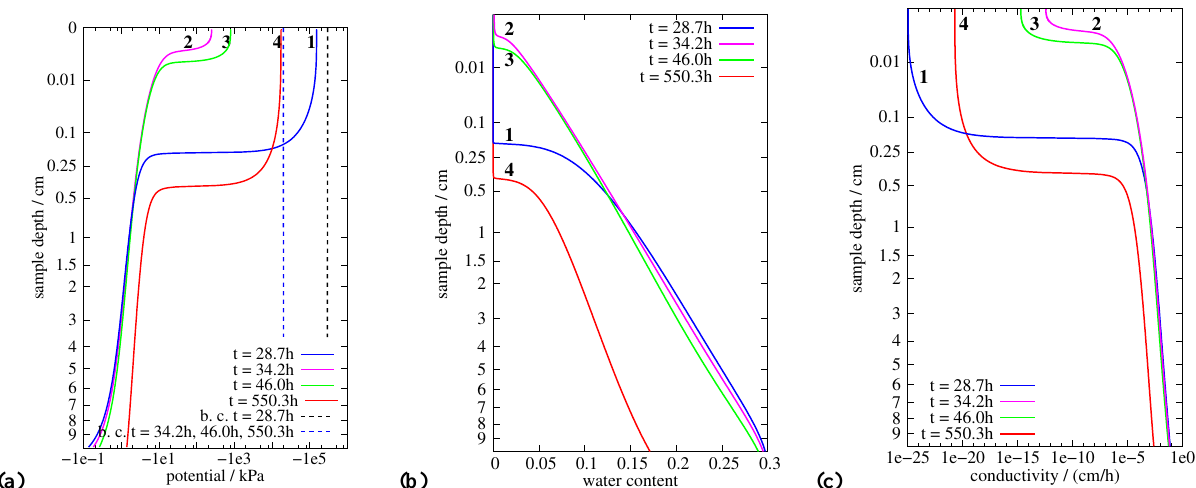
Fig. 7. Potential ψ m (z) (a) , water content θ(z) (b) and hydraulic conductivity K(θ(z)) (c) distributions for the twostep experiment with 20 times higher α : (1) directly before the first boundary condition switch, (2) after relaxation, (3) after re-entering regime II and (4) at the end of the experiment. Notice the non-linear scaling of the depth axis.